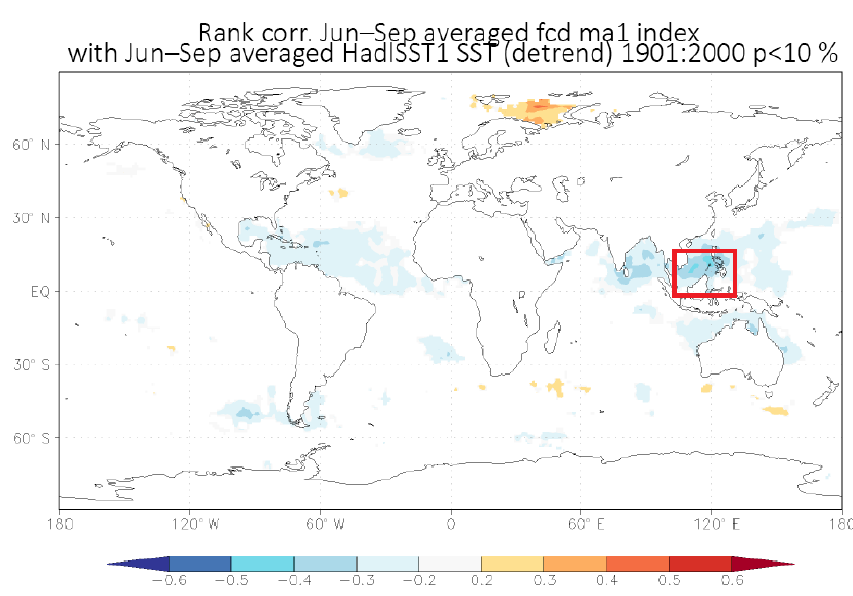
Figure 4. Spearman’s rank correlation between the CDI in Satara and SST field during the same JJAS season. SST region in the Indian Ocean (red box) that influences the CDI has a statistically significant correlation at the 95% significance